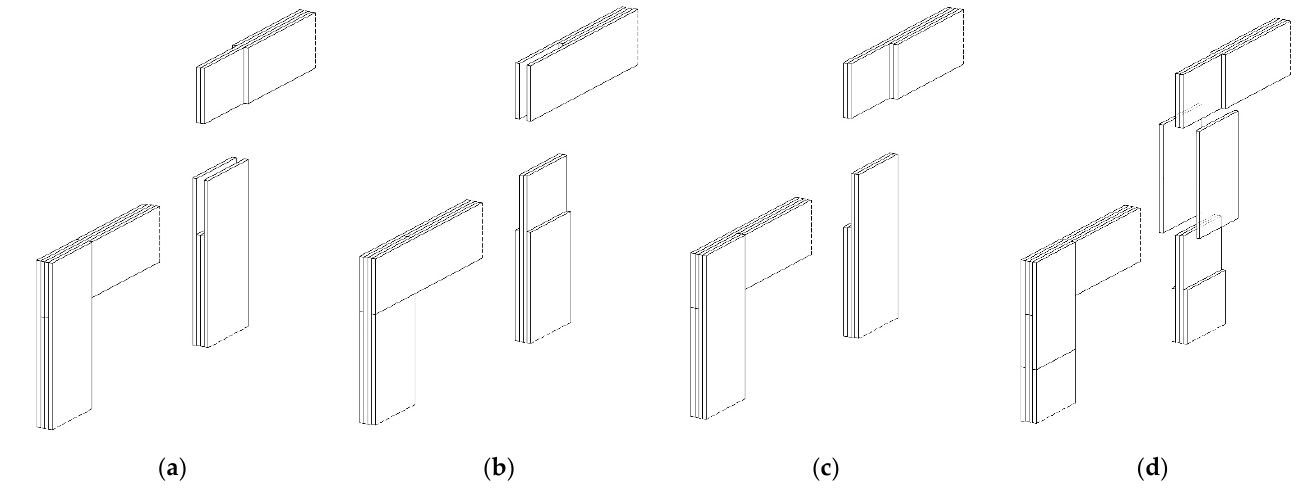
Figure 19. The types of connection glass layers in frames nodes: ( a ) tongue and groove; ( b ) tongue and groove; ( c ) single lap; and ( d ) cover layers (developed by the author based on the [99]).